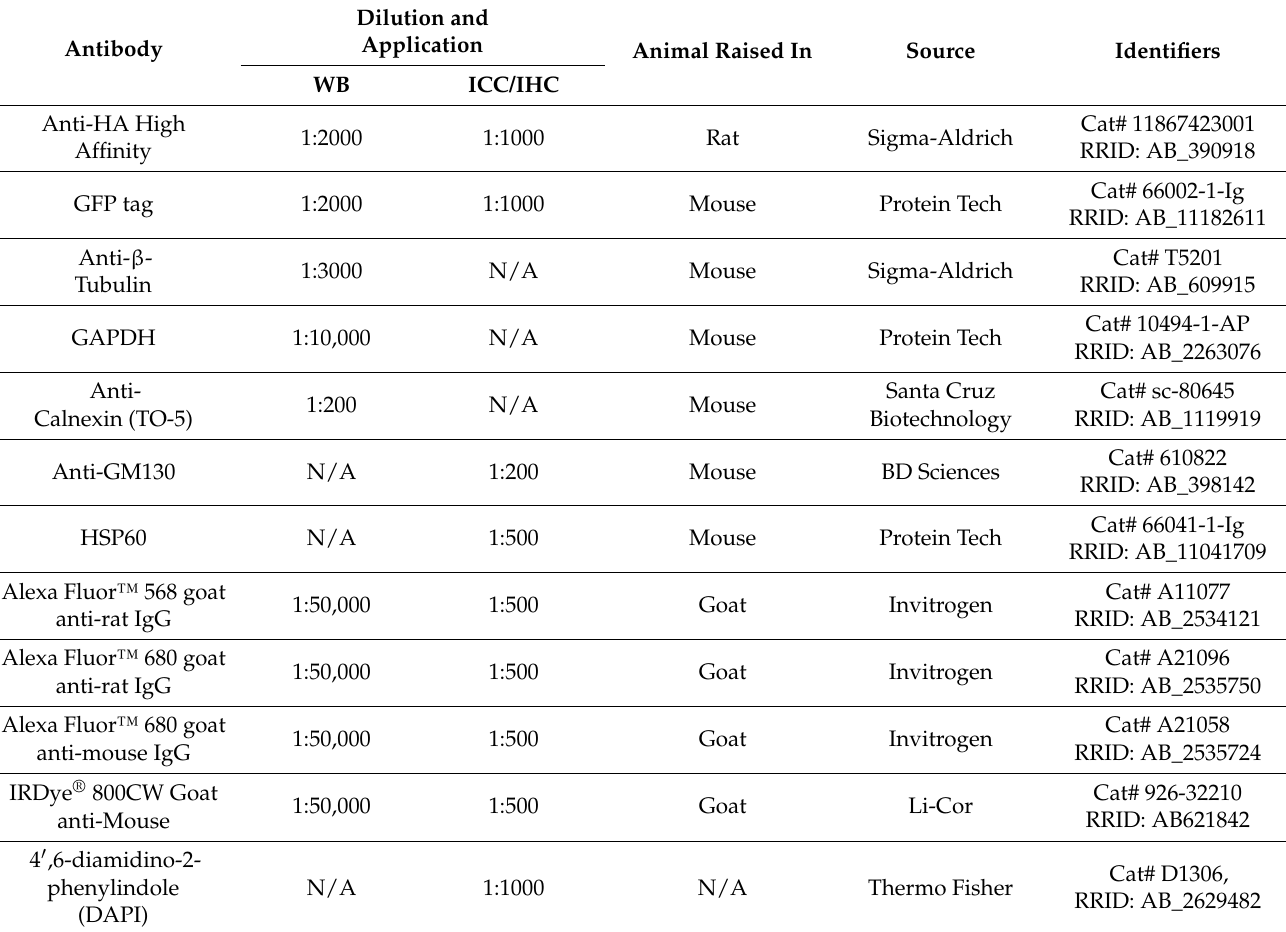
Table 1. Antibody